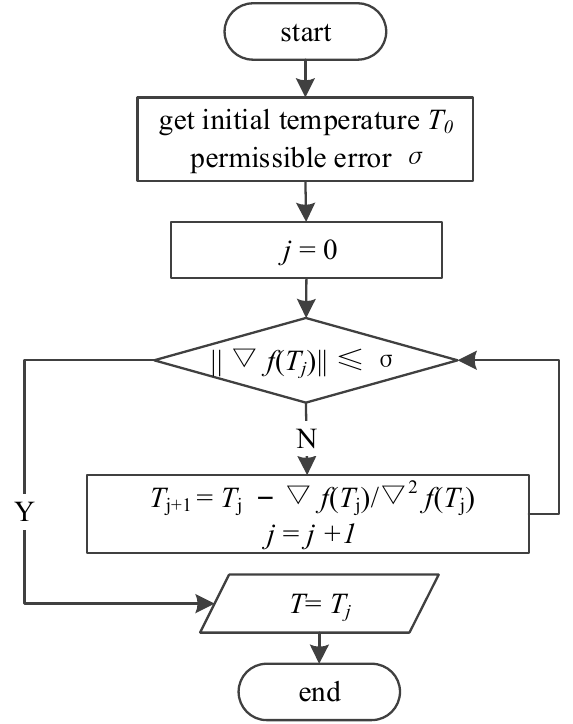
Figure 6. Flow chart of quasi-Newton method.